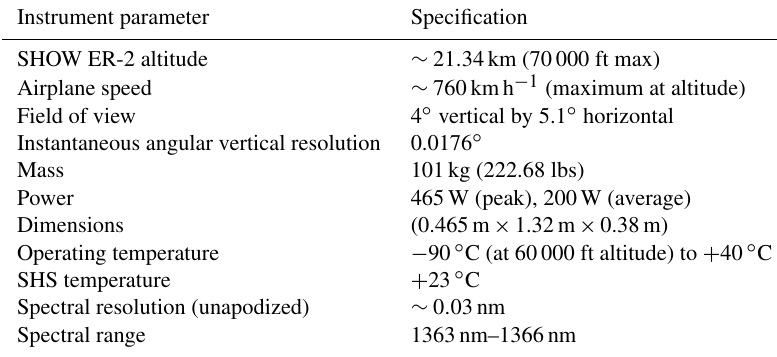
Table 1. SHOW ER-2 instrument